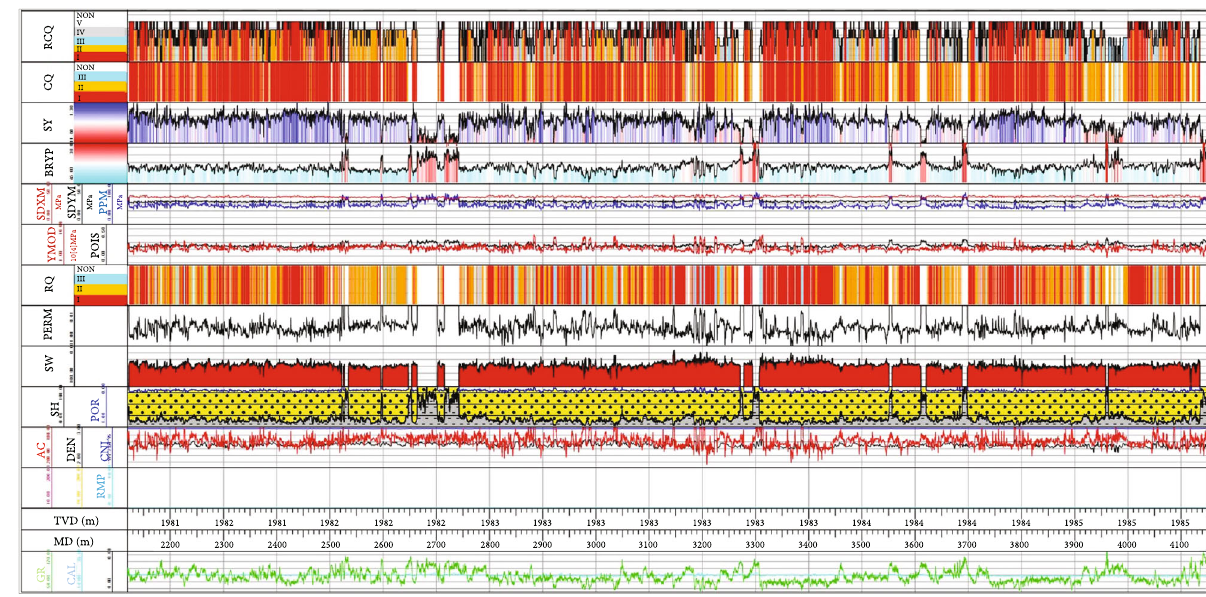
Figure 16: Integrated sweet spot identi fi cation in well Y.